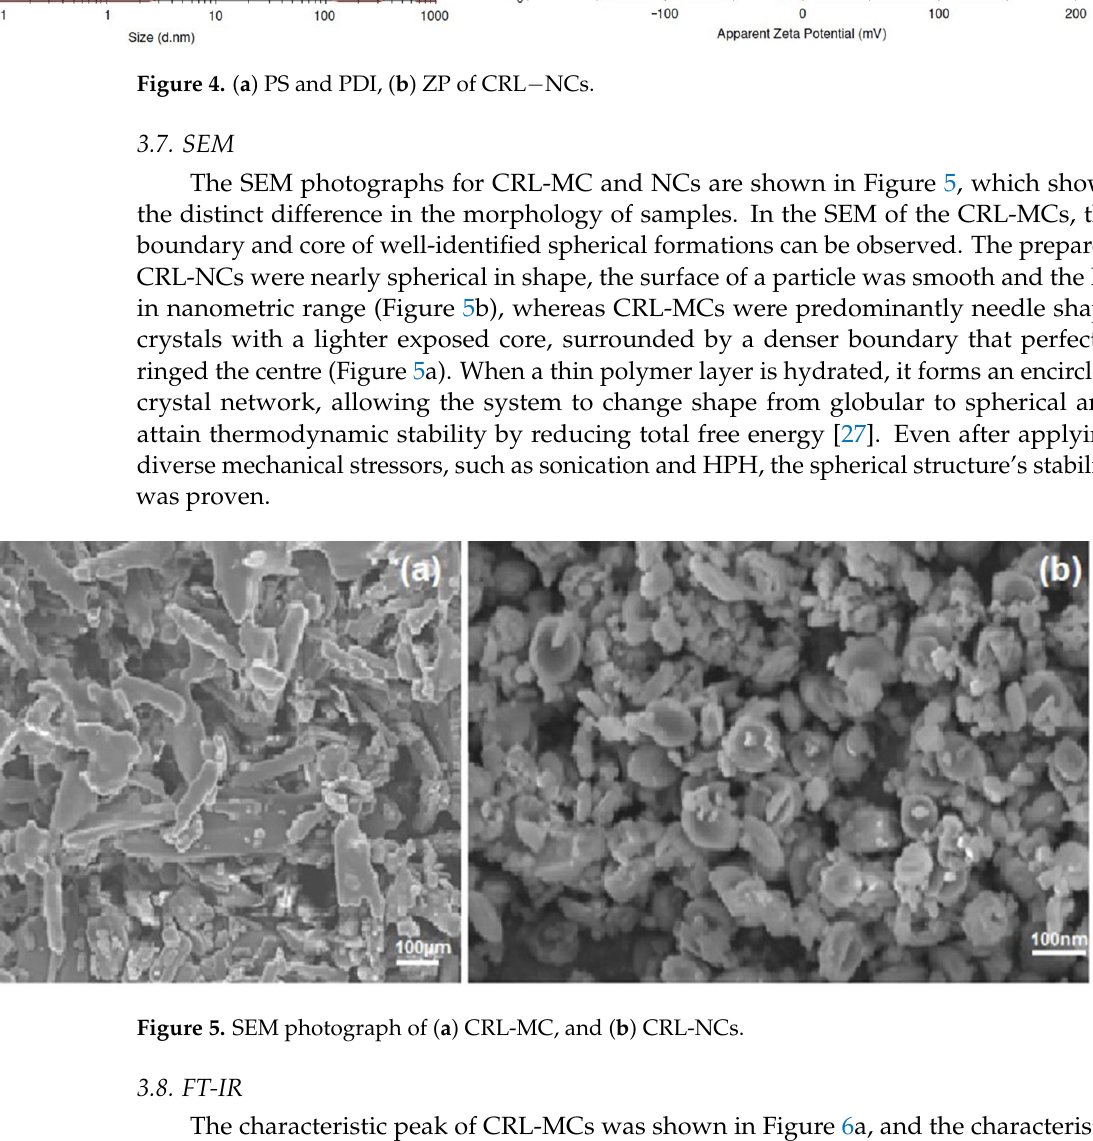
Figure 4. ( a ) PS and PDI, ( b ) ZP of CRL−NCs .